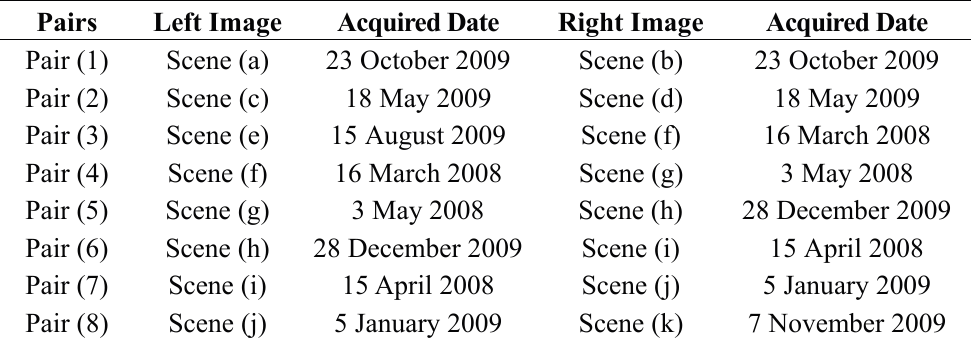
Table 3. Pairs of the tested Kompsat-2 images.